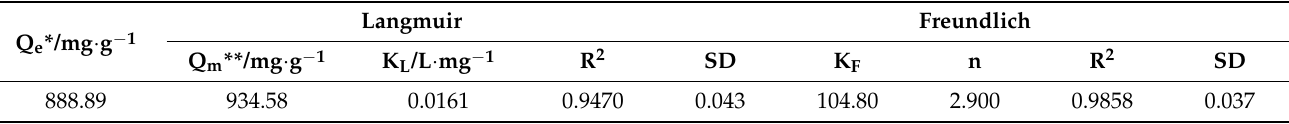
Figure 9. Isotherm models for Cu(II) ions adsorption onto MML: ( A ) Freundlich, ( B ) Langmuir. Table 1. Adsorption isotherm parameters of Cu(II) ions on MML.